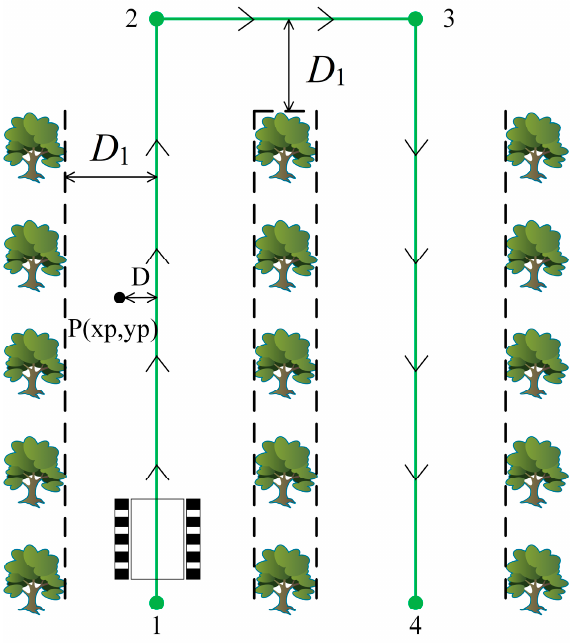
Figure 9. The path planning for the spraying robot in the citrus orchard.